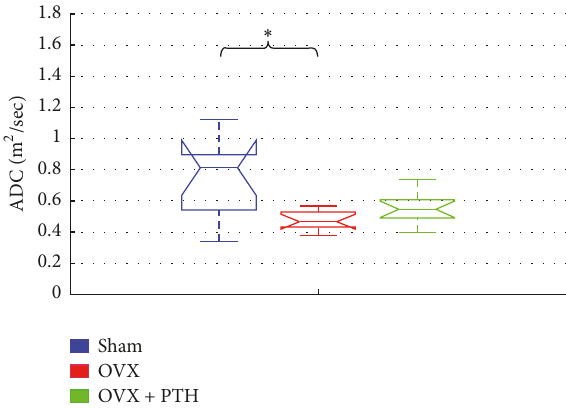
Figure 8: Prevention experiment: 𝑇 2 measurements 6 weeks after operation, measured at peripheral zone of metaphysis of tibiae bones.SignificantincreaseforthetibiaeOVXbonescomparedtothe OVX treated with PTH when measured in the peripheral zone of the bone marrow cavity (by Kruskal-Wallis test followed by Bonferroni multiple-comparison test ∗ 𝑃 < 0.006 ).